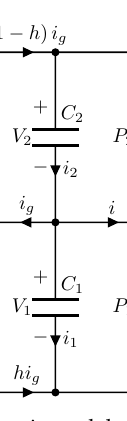
Figure 10. Average circuit model of the equalizer when V 1 > V 2